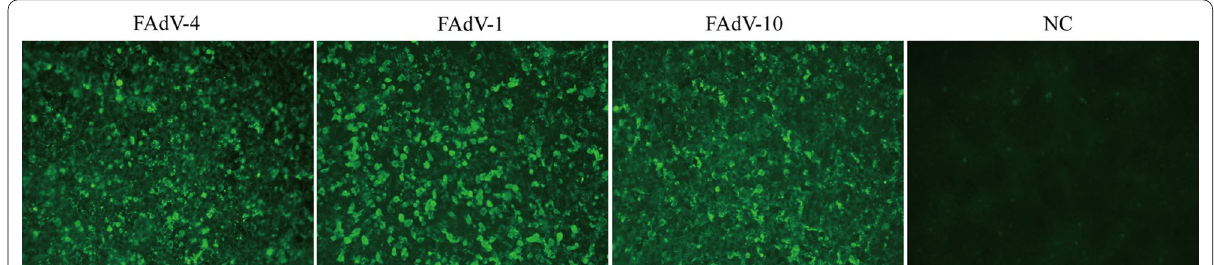
Fig. 5 Reactivity of the mAbs 3G8 with different serotypes of FAdVs by IFA. LMH cells were infected with FAdV-4, FAdV-1 and FAdV-10, respectively. At 70 h post-infection, the cells were incubated with mAb 3G8 and detected by IFA, respectively. LMH cells treated with PBS was used as negative control. mAb 3G8 was able to recognize all three serotypes of FAdVs